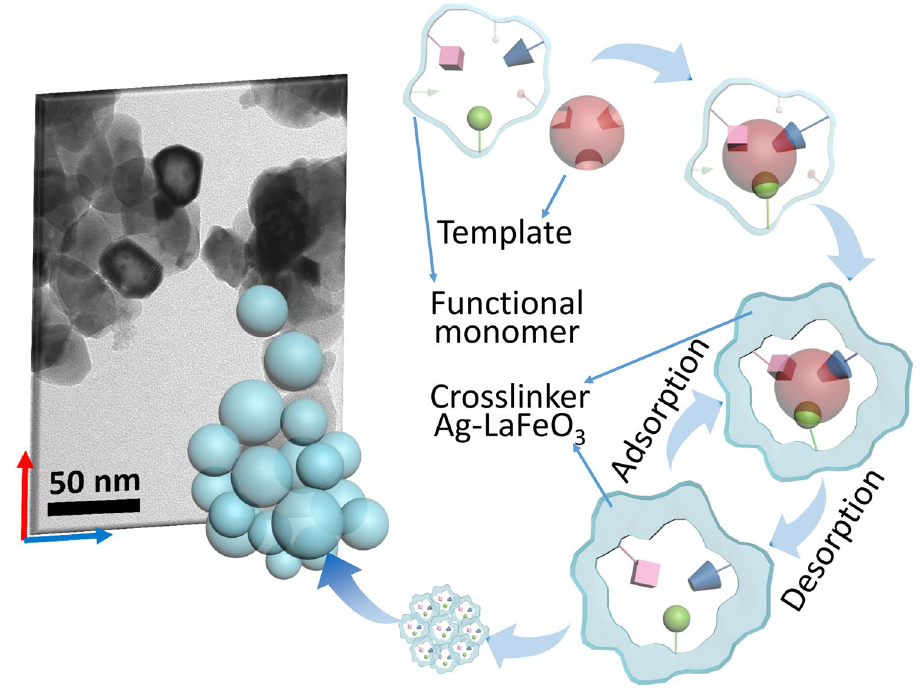
Figure 2. Schematic of the molecular imprinting